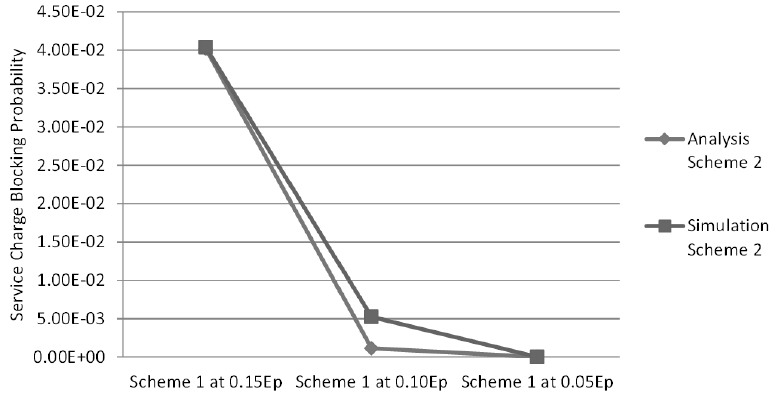
Figure 9. An example of analysis versus simulation results for the service load of 0.8 E